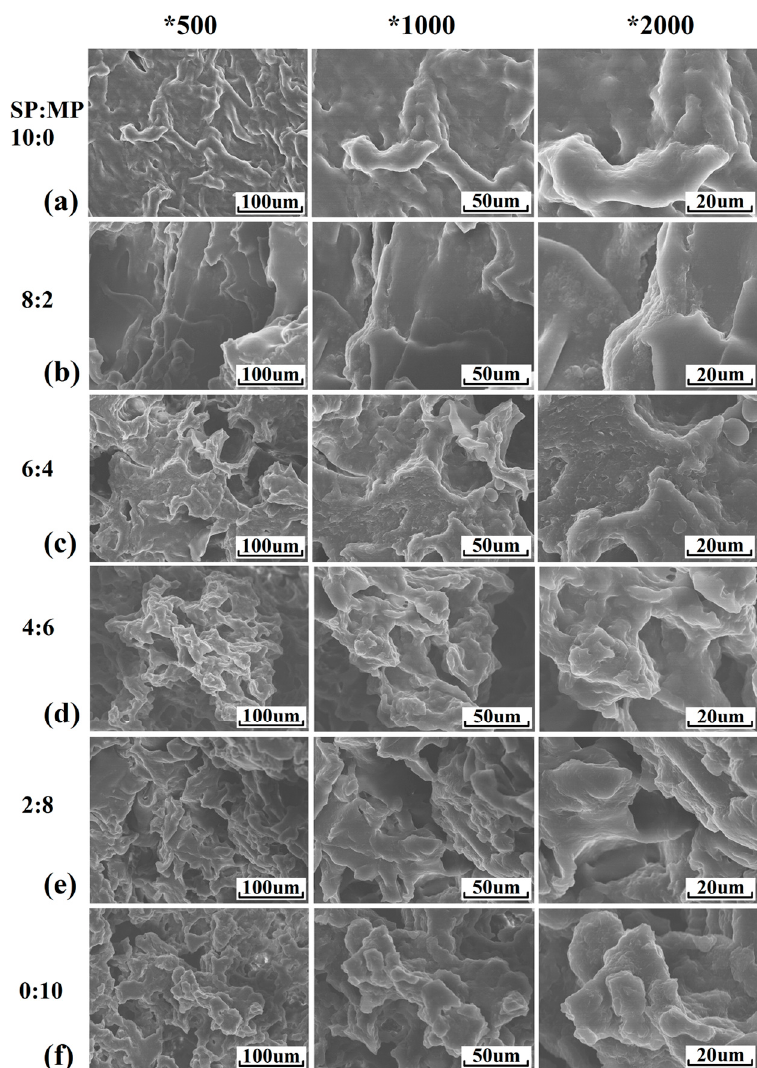
Figure 8. SEM graphs with different magnification times in the SP and MP system. SP/MP was set as